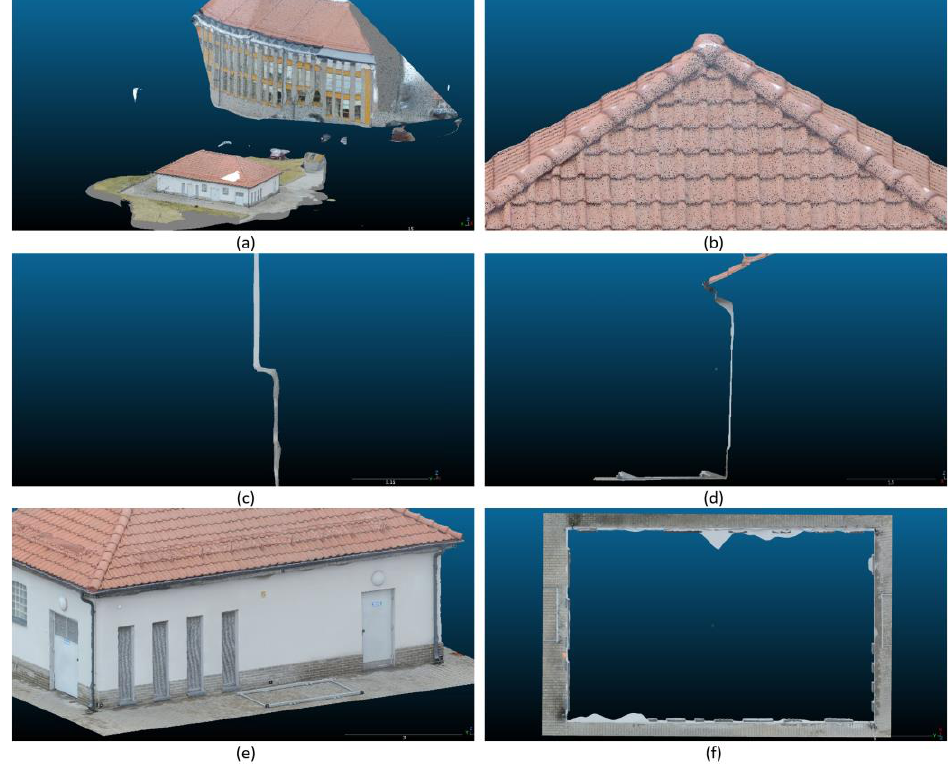
Figure 9. ContextCapture dense point cloud: ( a ) general look on generated point cloud; ( b ) roof geometry reconstruction; ( c ) place where clinker tiles contact wall without visible texture; ( d ) vertical section of elevation 1; ( e ) closer look at the corner of the building; ( f ) top view on the building without a roof.